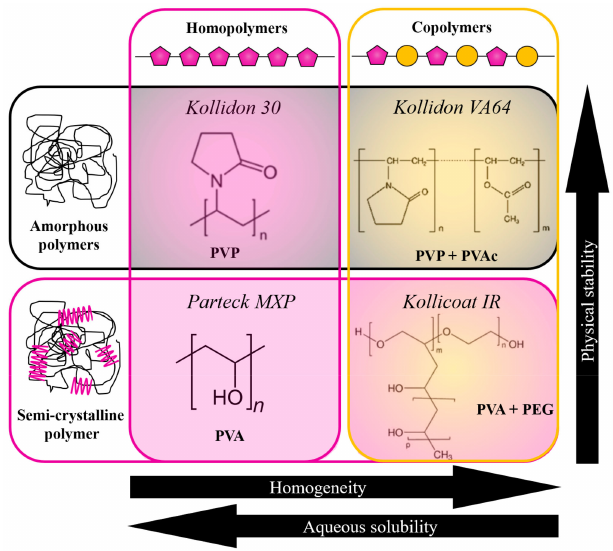
Figure 1. Schematic illustration of the types of polymers investigated in this work for POS-based